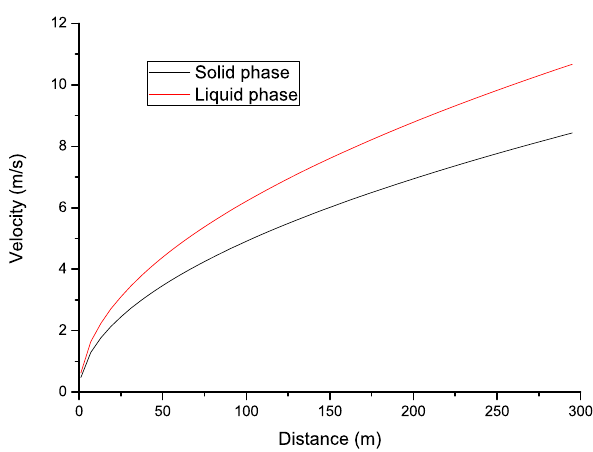
Figure 3. Solid- and liquid-phase velocities of a debris flow at the channel position x = 300m for different values of the solid volume fraction parameters: ρ s = 2400kgm − 3 , ρ f = 1500kgm − 3 , d e = 0.10m, ϕ s = 0.10–0.19, θ = 30 ◦ , ( τ B + µb)d 0 = 100, k = 3.72, g = 9.8.